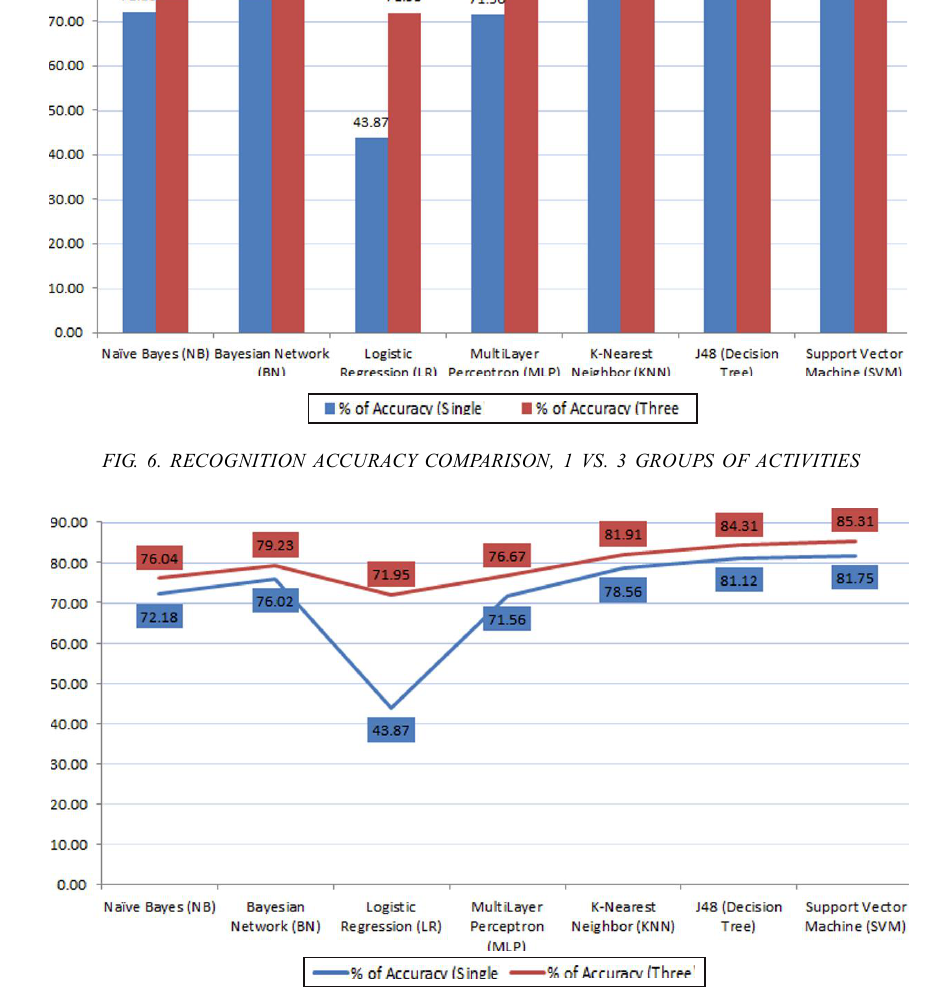
FIG. 7. RECOGNITION ACCURACY COMPARISON, 1 VS. 3 GROUPS OF